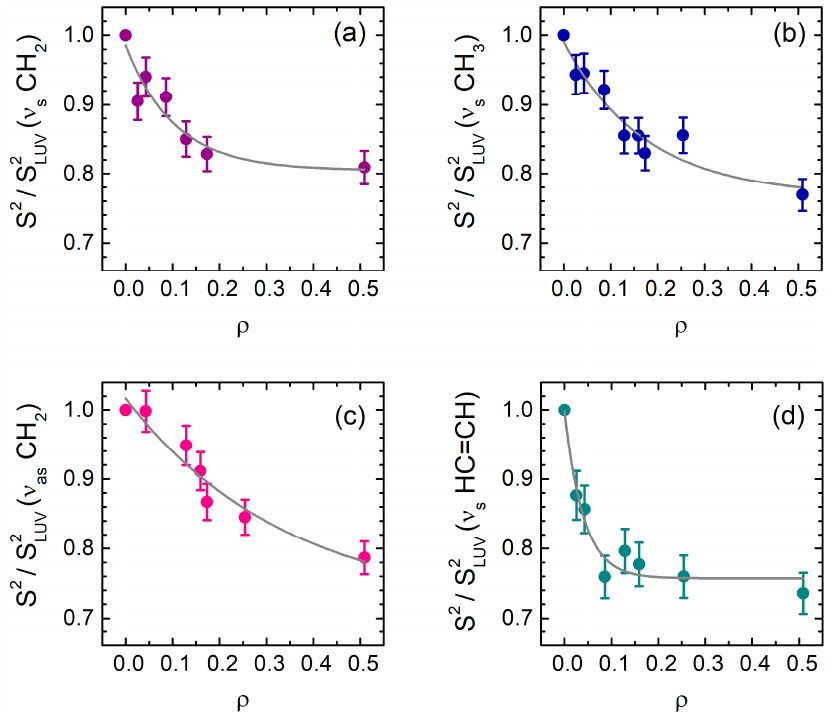
Figure 2. S 2 values for the principal spectral bands: ( a ) ν s (CH 2 ) at 2855 cm − 1 , ( b ) ν s (CH 3 ) at 2873 cm − 1 , ( c ) ν as (CH 2 ) at 2927 cm − 1 , and ( d ) ν (CH=CH) at 3012 cm − 1 peaks, as a function of ρ , normalized to the value obtained from the pure LUV spectrum, with exponential fit of the data.